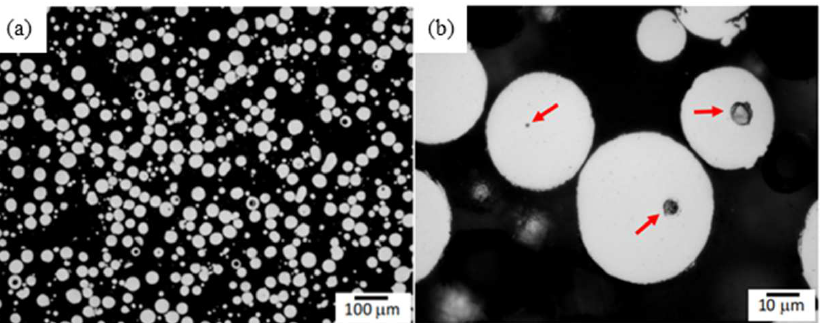
Figure 16. Light optical micrographs of as-polished cross sections of raw 316L SS powders: ( a ) Low magnification showing the particle size distribution and inherent gas pores inside the powder particles; ( b ) Individual powder particles show small spherical gas pores (marked by arrows) [87].